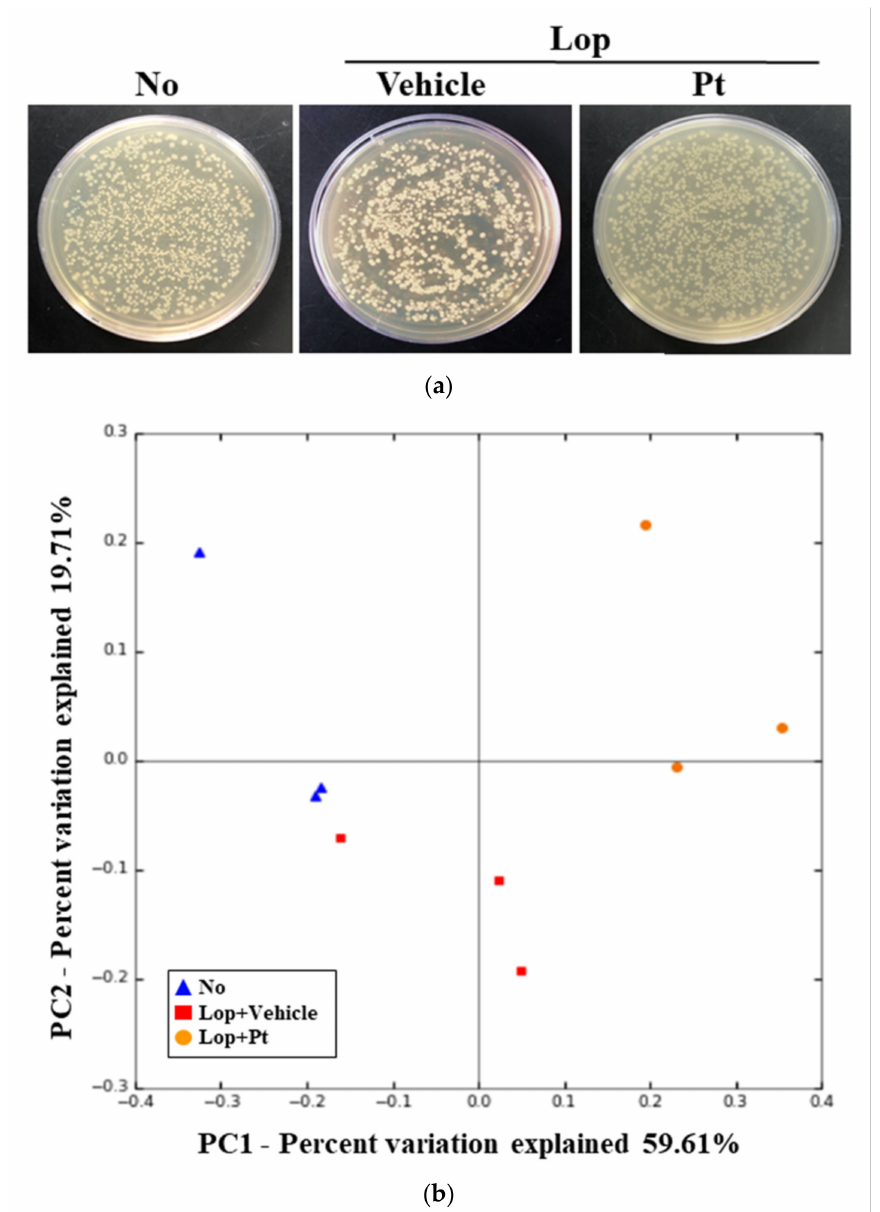
Figure 7. Overall analysis of fecal microbiota. ( a ) Cultivation image of fecal microbiota. After incubation for 24 h, microorganism colonies grown on nutrient agar were analyzed in a view box. ( b ) PCoA plot analysis. PCA focused on alterations of stool bacterial communities using principal components in the non-treated (No), Lop+Vehicle-treated, and Lop+Pt-treated groups. The spatial distance measure represents the degree of similarity of bacterial taxa in the stool samples. Non-treated (No): blue triangle; Lop+Vehicle: red rectangle; and Lop+Pt: orange circle. Abbreviations: Lop, loperamide; Pt,